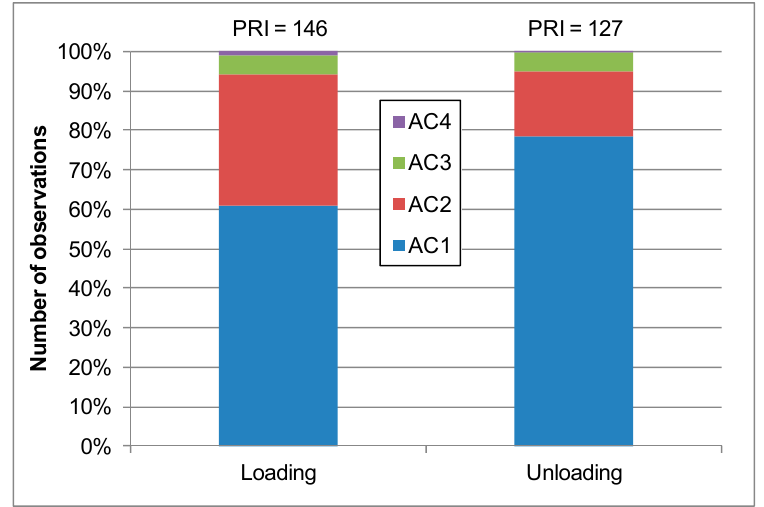
Figure 2. Percentage breakdown of observations among postural risk classes and overall postural risk index. Notes: PRI = postural risk index; AC = Action class, as estimated with the OWAS method; n = 1200; AC1 = Normal posture, AC2 = Slightly harmful posture, AC3 = Distinctly harmful posture, AC4 = Extremely harmful posture.